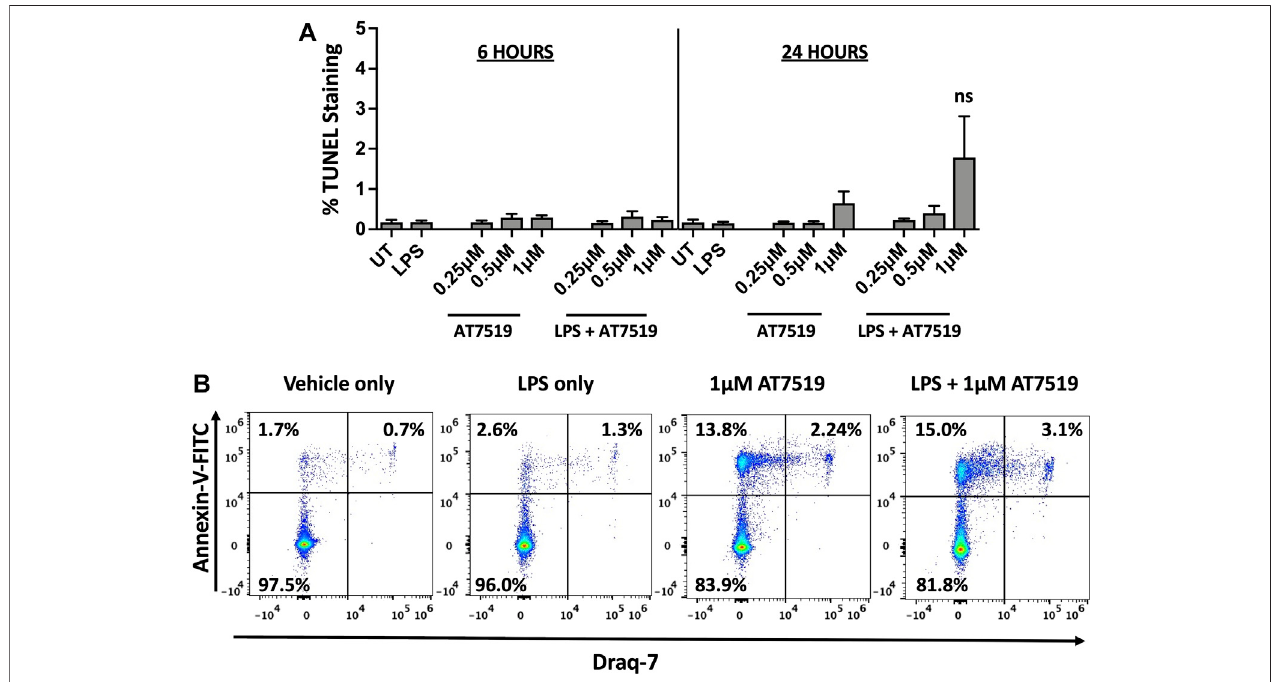
FIGURE3| TreatmentofhumanMDMswithAT7519doesnotaffectcellviability. (A) QuantitationofTUNELpositiveMDMstreated±AT7519and±LPSasshown, at 6 and 24 h. Quantitation is shown as the percentage of TUNEL positive cells compared to the total cell population stained with Hoechst. UT = untreated. ns = no signi fi cant difference. (B) Representative Annexin V/Draq-7 fl ow cytometry plots of MDMs treated with vehicle-only, LPS-only, 1 μ M AT7519, or 1 μ M AT7519 + LPS, showing no increase in Annexin V/Draq-7 double positive cell numbers (upper right quadrants) in cells incubated with AT7519 + LPS versus AT7519 alone.